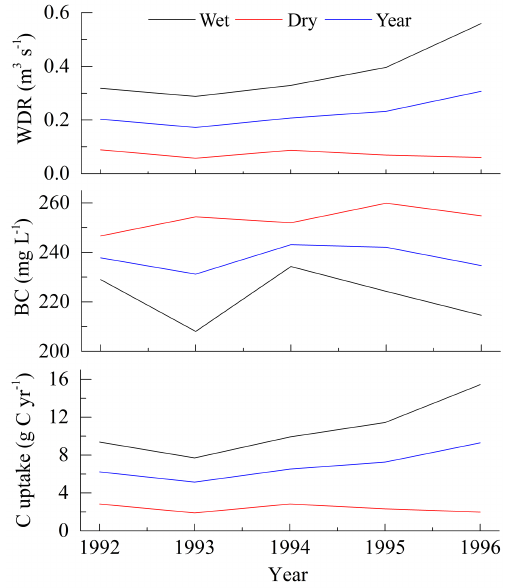
Figure 3. Variation in run-off, ion concentration, and carbon sink for the LG station (1992–1996).